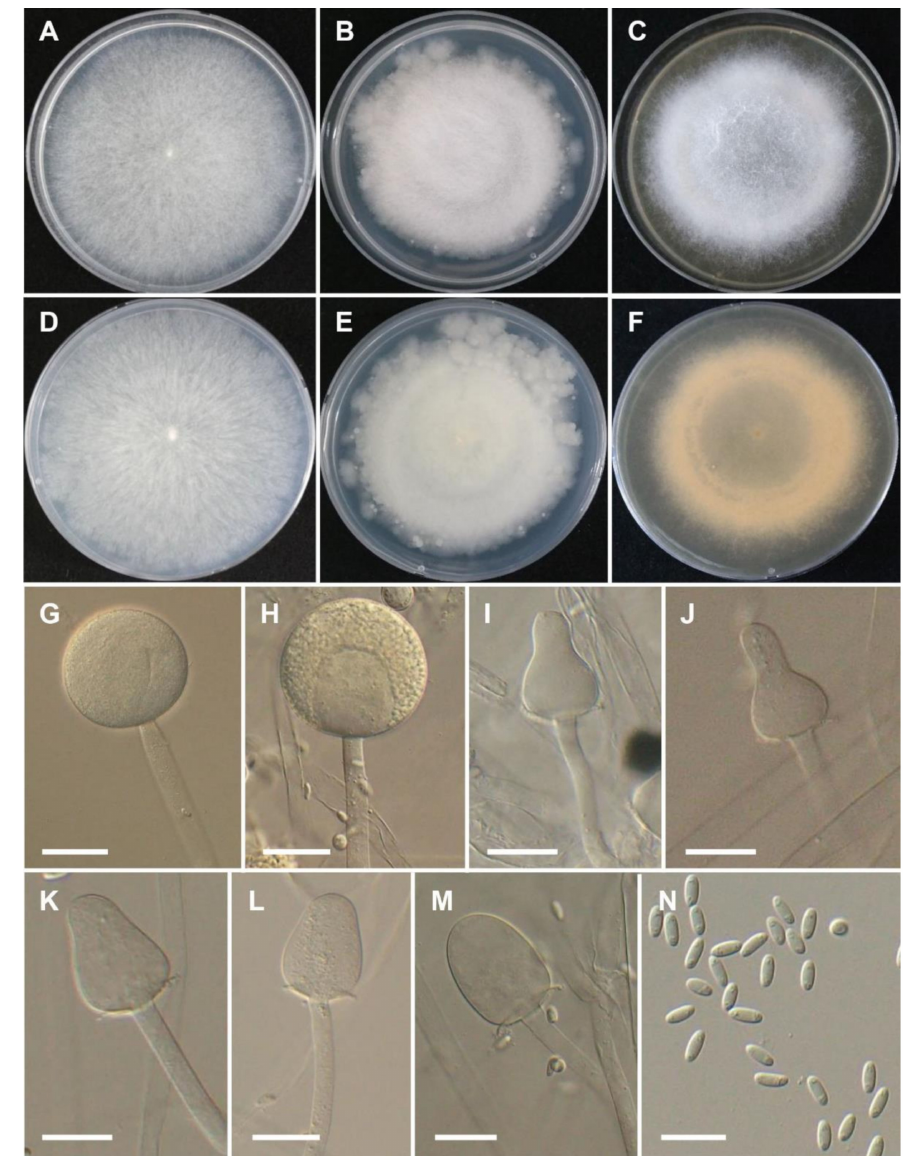
Figure 3. Morphology of Mucor grylli . ( A , D ) Colony on synthetic agar mucor (SMA). ( B , E ) Colony on potato dextrose agar (PDA). ( C , F ) Colony on malt extract agar (MEA). ( G , H ) Young and mature sporangia. ( I – M ) Typical columellae. ( N ) Sporangiospores. Scale bars = 20 µ m. Mucor hyangburmii T.T.T Nguyen sp. nov. (Figure